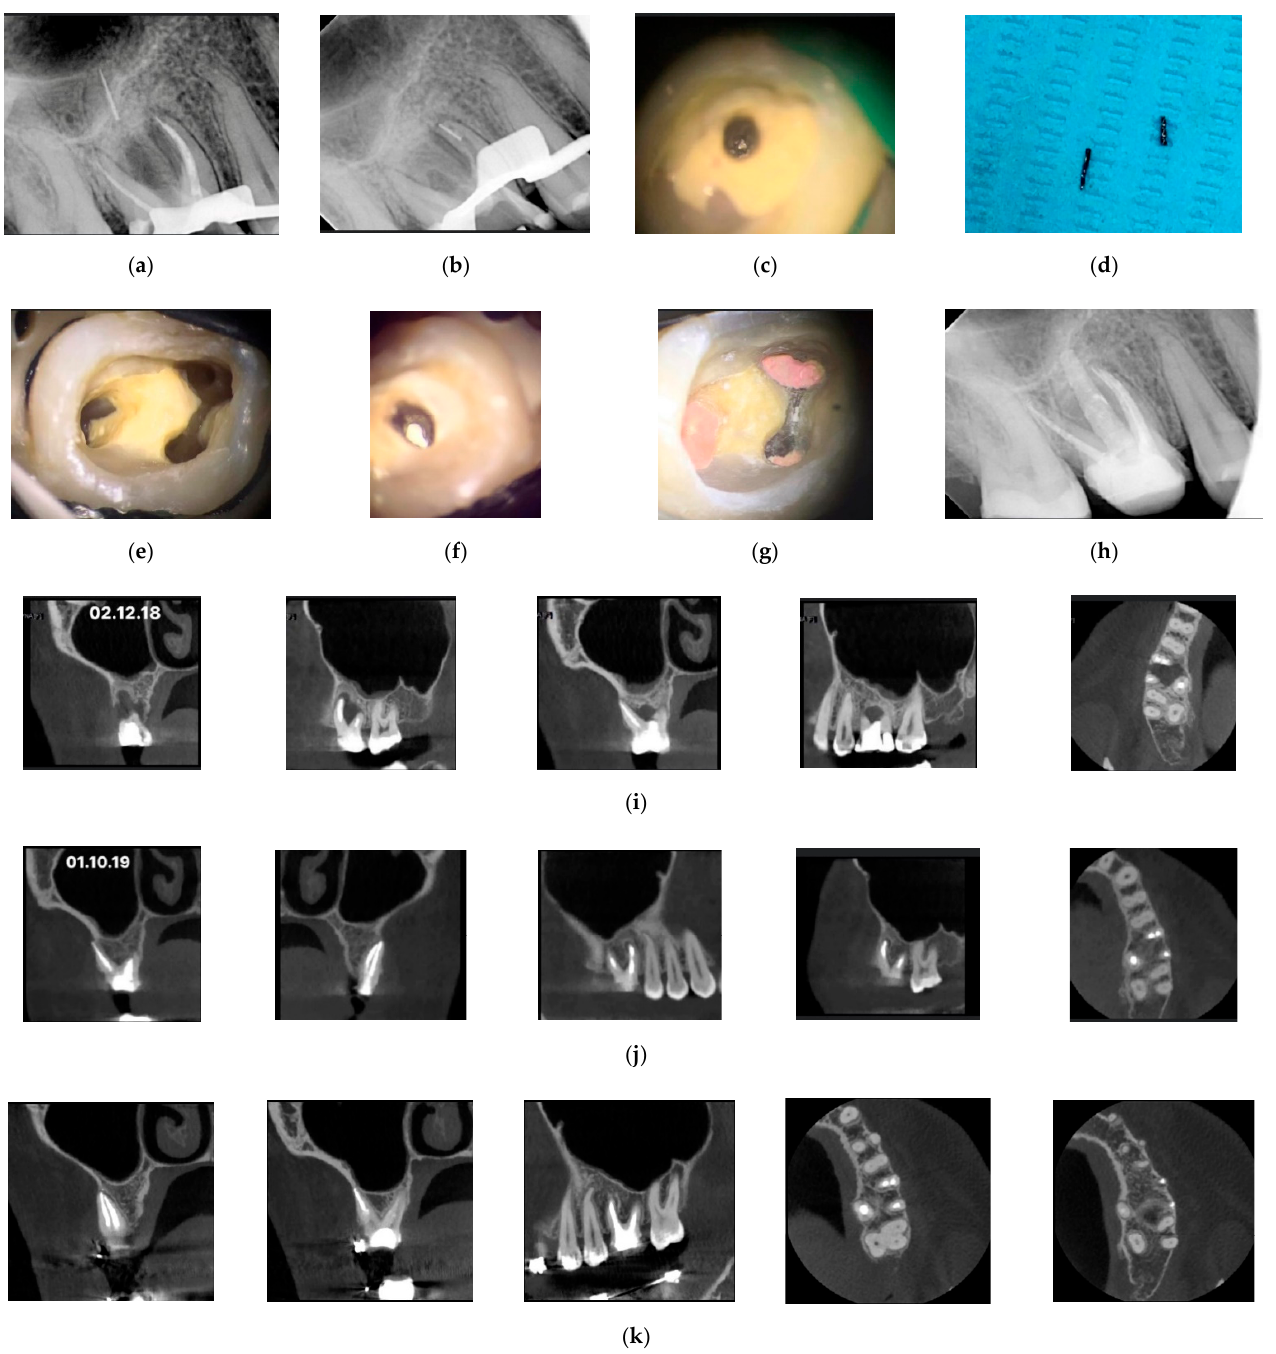
Figure 2. ( a , b ) Preoperative periapical radiographs of the first upper molar, presenting the “bone” defect as a radiolucent area with irregular contour in the apical region and in the bifurcation region. ( c , d ) Stages of removal of fragments of endodontic instruments from the buccal medial and palatal canals. ( e ) Tooth appearance after instrumentation of the root canals. ( f ) Introduction of BioDentin into the palatal canal. ( g ) Root canal obturation. ( h ) Postoperative periapical radiograph. ( i ) Diagnostic CBCT. ( j ) Follow-up CBCT 11 months later. ( k ) Follow-up CBCT 24 months later.